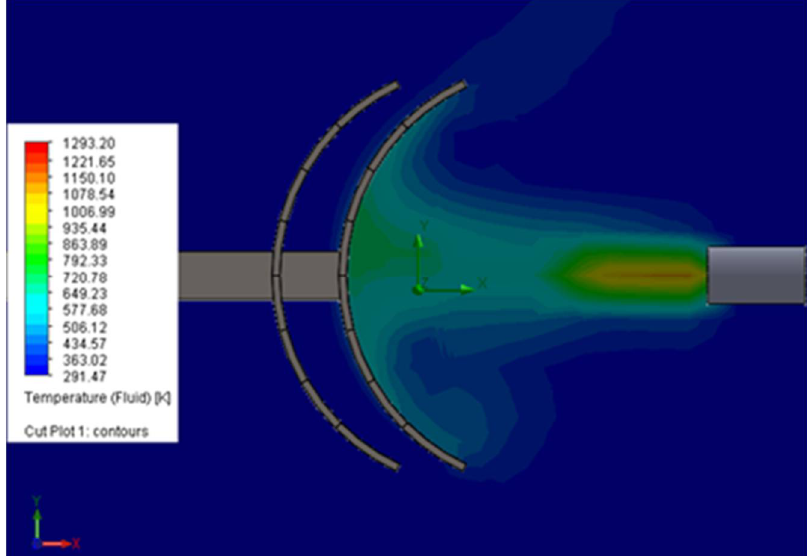
Figure 23. Air temperature simulation for an output speed of 10 m/s. The numerical simulation was performed using the finite element simulation application Solid Works.